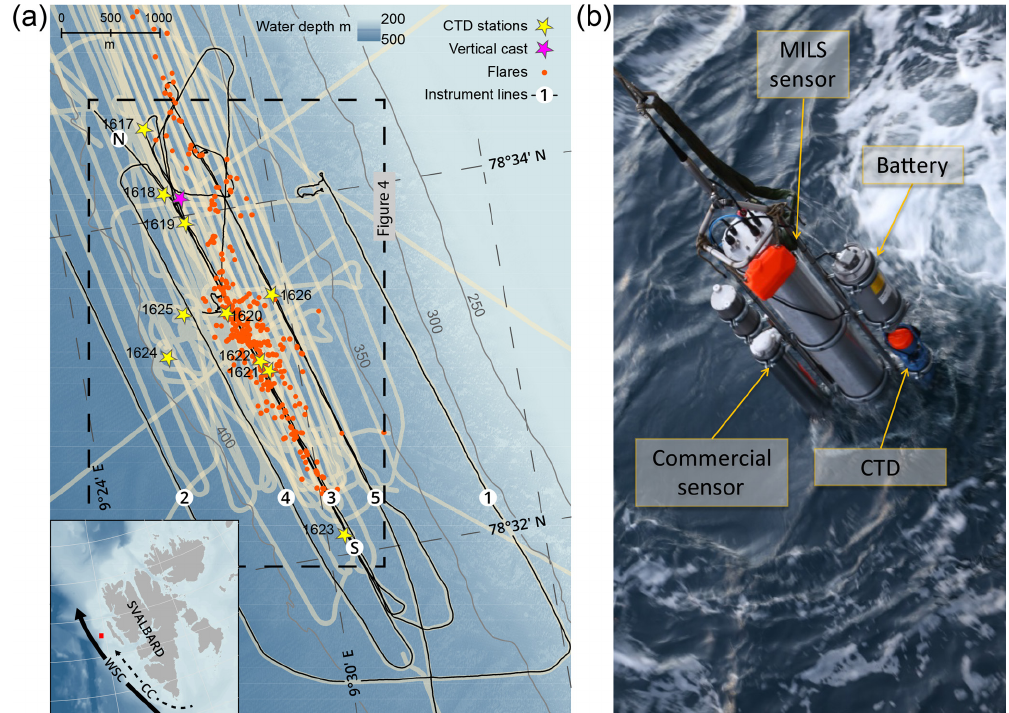
Figure 1. Map of the surveyed area and photo of the instrument assembly. (a) Survey lines and sampling locations over the study area at the Svalbard continental margin. Black lines show the ship trajectory with line numbers assigned in the order they were surveyed. Beige areas appearing as thick lines indicate echo-sounder beam coverage from this campaign and previous cruises (AOEM 2010 and CAGE 13-7 in 2013). The start and end locations of line 3 are indicated with N and S, respectively. Known flare locations from this survey and surveys in 2010 and 2013 are marked with orange dots. CTD stations with discrete water sampling are marked with yellow stars and the vertical instrument cast with a purple star. The inset image shows an overview of Svalbard with the survey location indicated with a red square. The controlling currents are shown with solid (WSC) and dashed (coastal current) black lines. The bathymetry was obtained from IBCAO version 3.0 (Jakobsson et al., 2012). (b) Instrument assembly: the main central tube is the prototype MILS sensor. The stainless steel frame acts as a platform and allows for attachment of the instrument battery (top-right side), CTD (blue at the bottom right), and a commercial CH 4 sensor and its battery pack (left